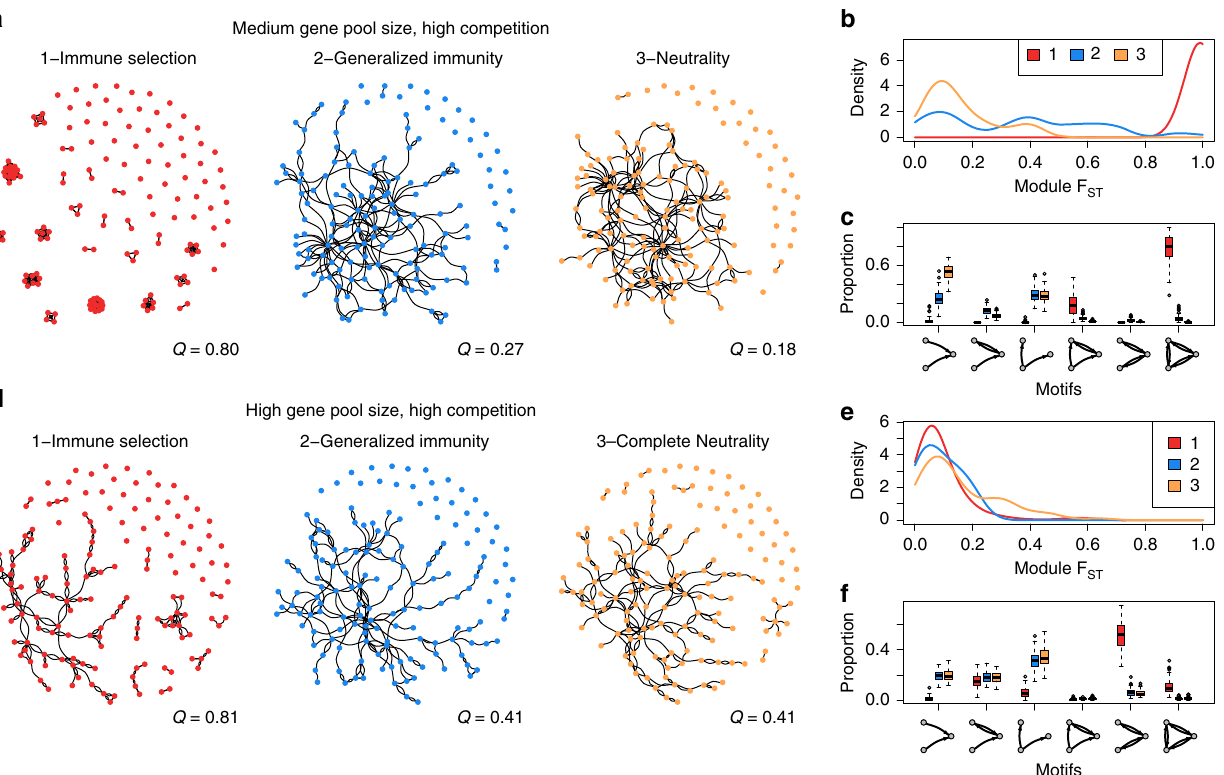
Fig. 2 Population structure for the three different models quanti fi ed using network properties. Shown here are repertoire similarity networks and representative network metrics across scenarios under different diversity regimes generated from model simulations with high competition (high duration of naive infection and high transmission rates). Upper panel, medium diversity (gene pool size of 1,200) and lower panel, high diversity (gene pool size of 24,000). a , d Comparisons of repertoire similarity networks of 150 randomly sampled parasite var repertoires from one time point under three scenarios. Edge width is relative to the strength of genetic similarity between pairs of repertoires. Only the top 1% of edges are drawn and used in the analysis (see Supplementary Fig. 3 for distribution of edge weights). Within the largest component of each network, the size of each repertoire is relative to its normalized betweenness centrality. The value of maximum modularity Q is calculated using edge betweenness 30 and is shown at the lower right corner of each network. The modules obtained in these networks represent groups of highly similar repertoires (strain modules), which are conceptually similar to geographically isolated populations with limited gene fl ow. We therefore calculate the pairwise F ST of strain modules, to quantify how different strain modules are from each other, providing a measure of limiting similarity that compares within-module and between-module diversity 64 . b , e Pairwise module F ST distributions of 100 repertoire similarity networks per scenario. c , f Distributions of the proportion of occurrences of three-node graph motifs for the three models across 100 repertoire similarity networks. The box shows the interquartile range (IQR, from the 25th to the 75th percentile of the distribution), and the lower and upper whiskers correspond respectively to 1.5 IQR of this lower quartile and 1.5 IQR of the upper one, with the median indicated with a line and points displaying